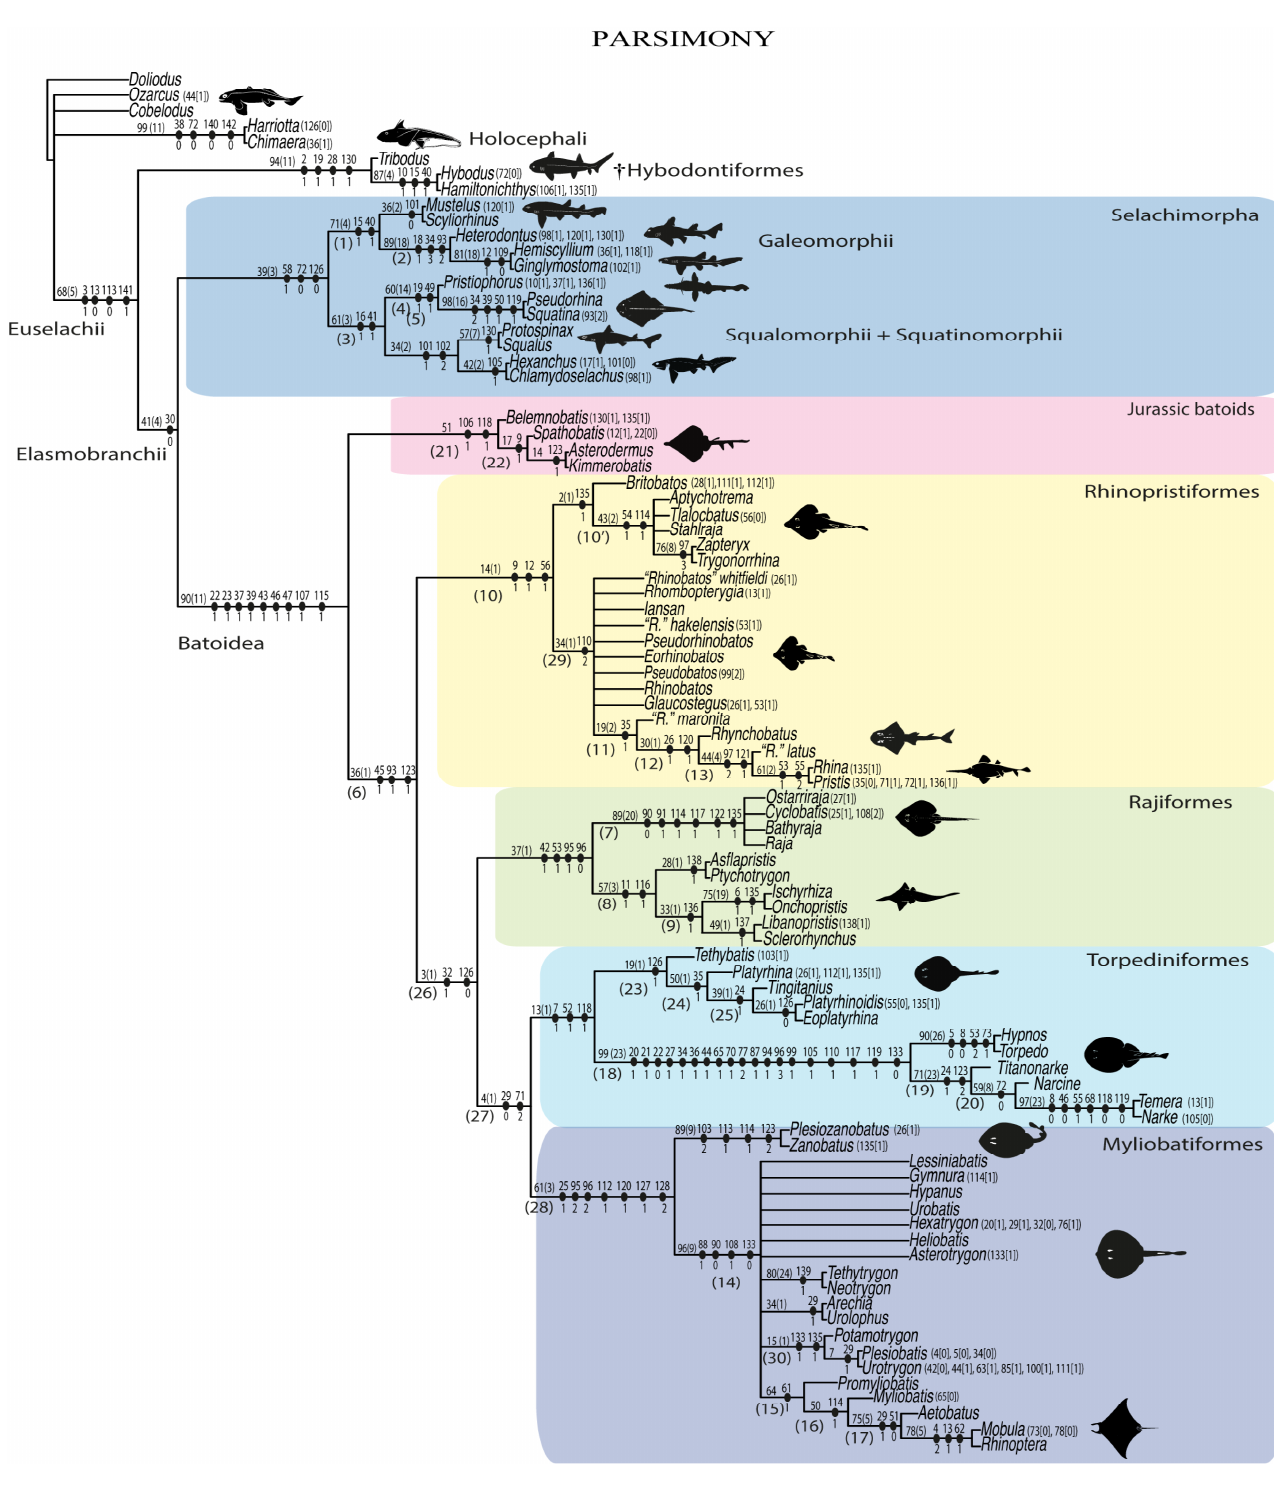
Figure 49. Strict consensus tree estimated from the TNT analysis. Largest groups recovered in the analysis are marked with different symbols. For the full character list see the Supplemental Material. Clade numbers in parenthesis.